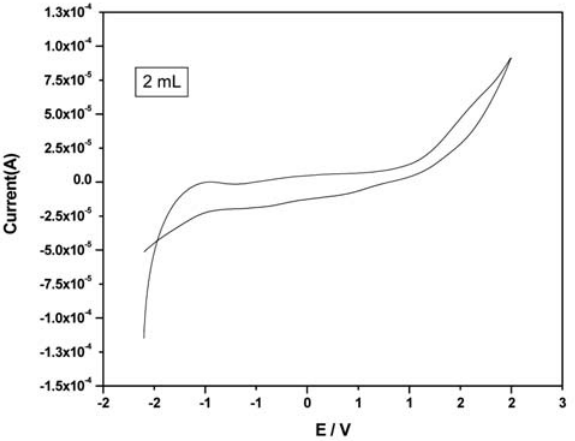
Figure 2a. Cyclic voltammograms interpretation of 5a in acetoni- trile